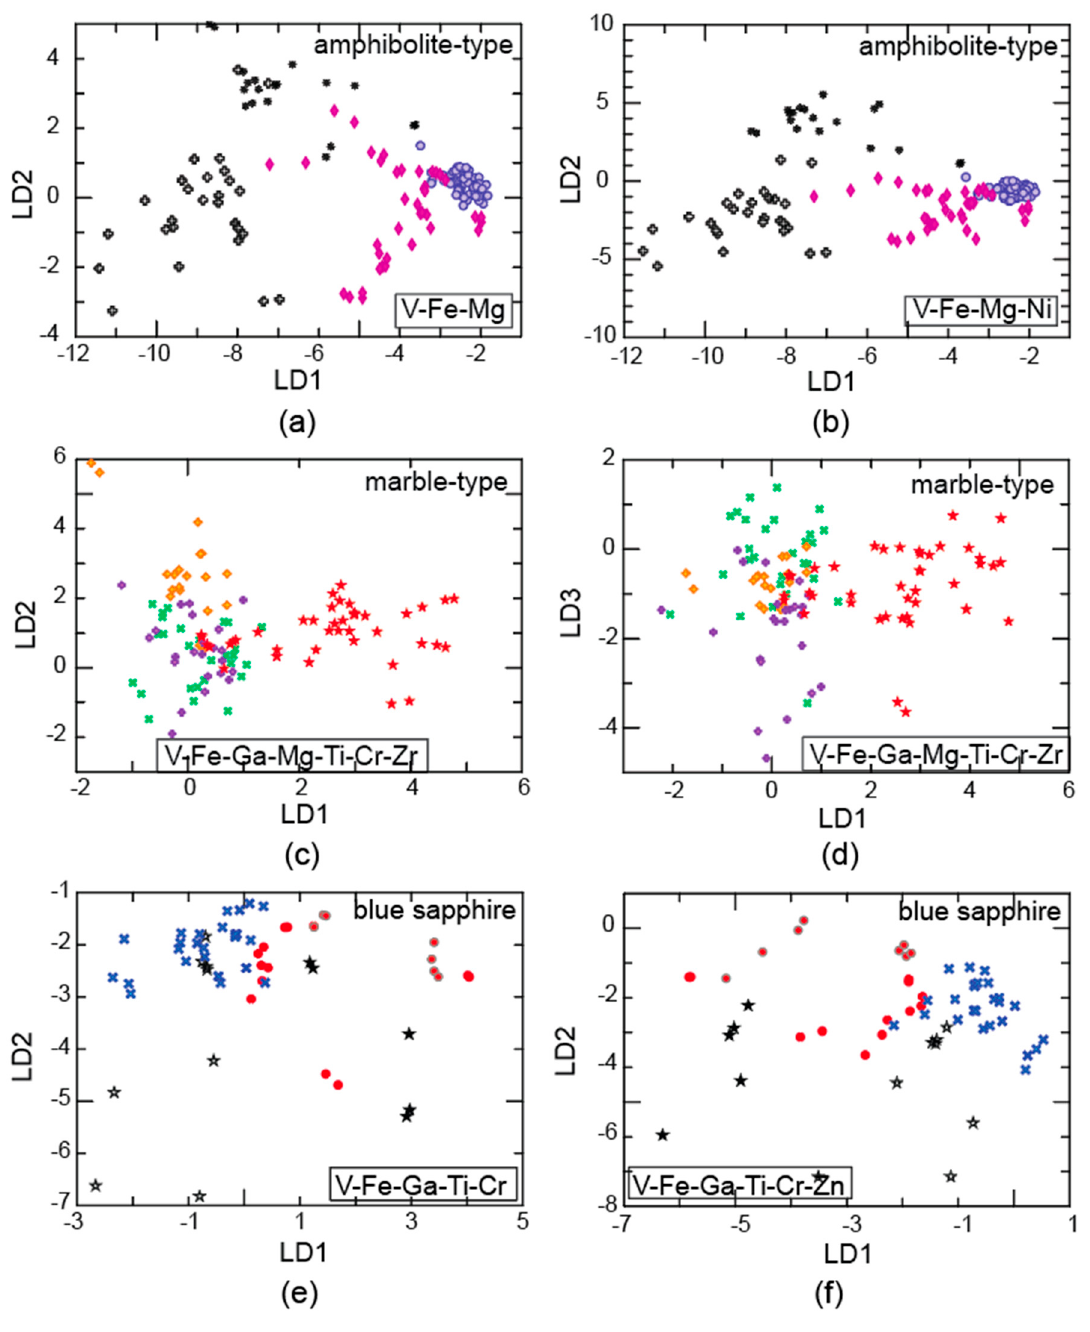
Figure 15. Linear discriminant analysis (LDA) solution for ( a ), ( b ) amphibolite-type rubies; ( c ), ( d ) marble-type rubies; and ( e ), ( f ) metamorphic blue sapphires. Elements used in method calibration are inset on each figure. Symbols as in Figure 11.